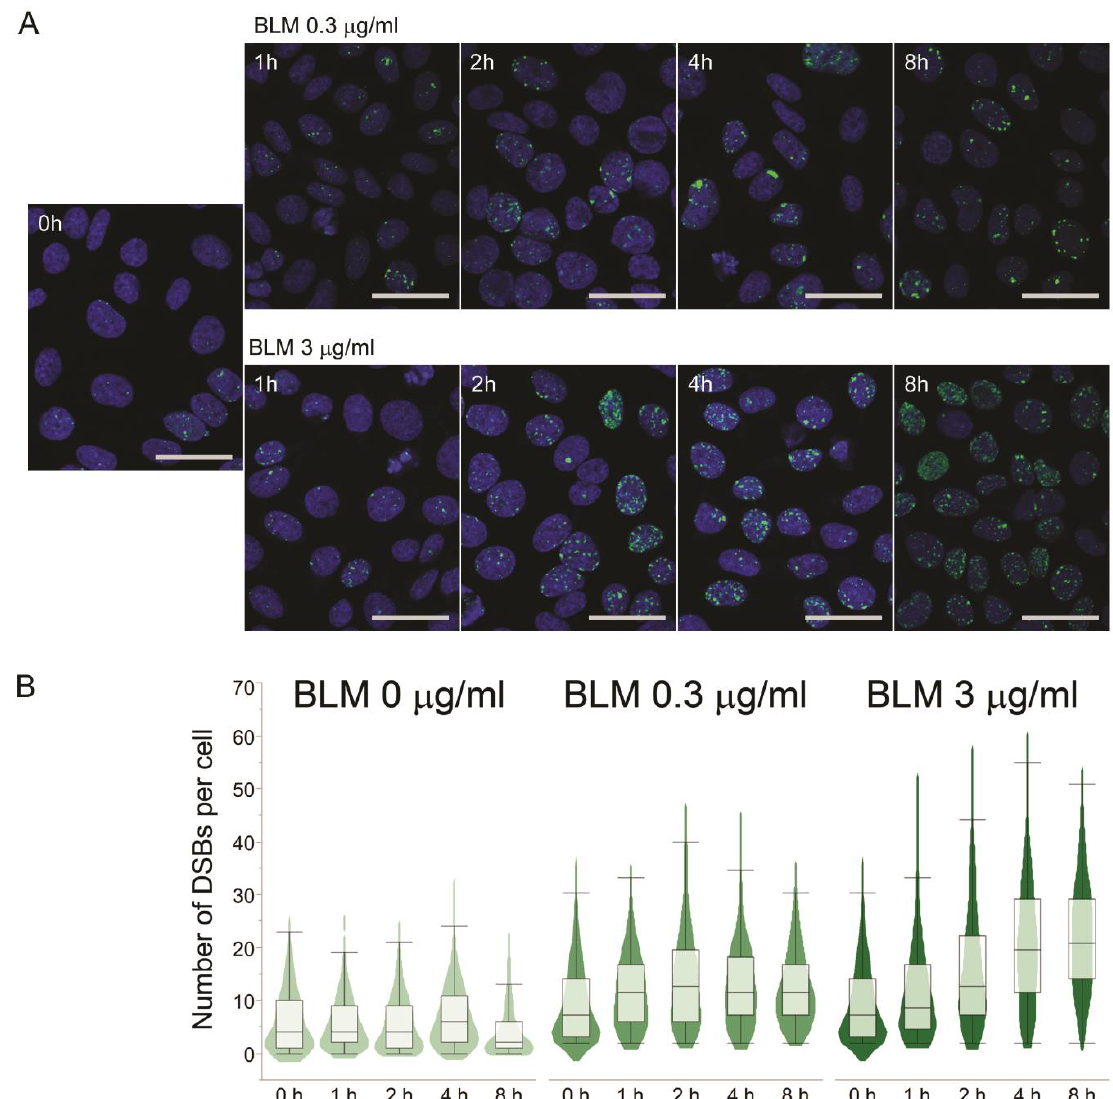
Figure 3. ( A ) Immunocytochemistry of phosphorylated histone 2A Variant X (γH2AX (green foci)) on CHO-DUK cells treated with 0.3 µg/mL and 3 µg/mL of bleomycin. The nuclei were counterstained with 4’,6-diamidino-2-phenylindole (DAPI). ( B ) The number of double-strand breaks (DSBs) per cell were counted and are shown in the contour and box plots. The distribution of cells is indicated in the thickness of the contour plot, whereas the median number, upper and lower quartiles, and upper and lower 95% ranges are presented in the box plot at each time point. The scale bars are 20 µm. BLM, bleomycin.